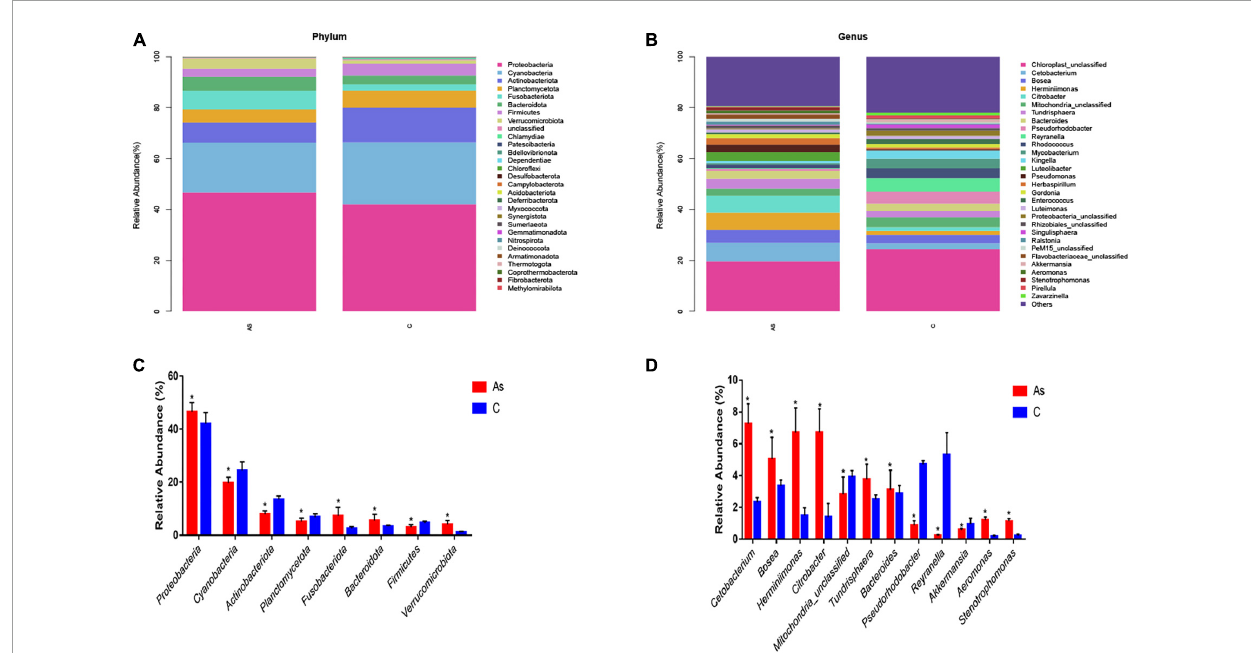
FIGURE6 Relative abundance and differences in the intestinal flora at the phylum and genus levels. (A,B) Relative abundance and differences at the phylum level, respectively. (C,D) Relative abundance and differences at the genus level, respectively. * P < 0.05 indicates a significant difference between the two groups.